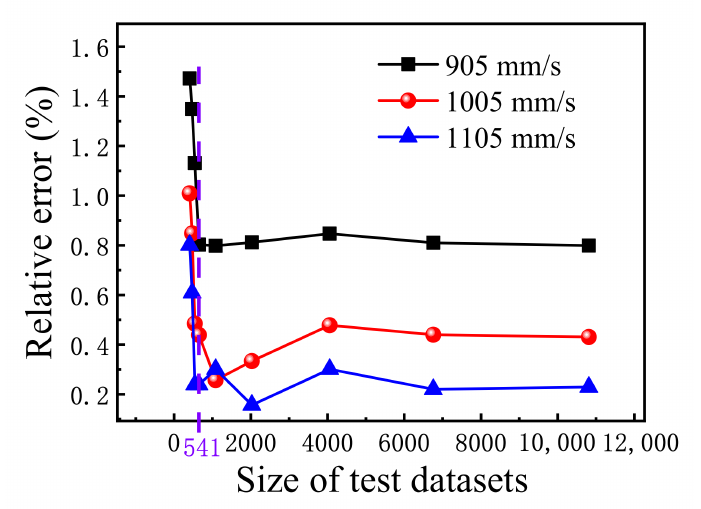
Figure 4. The predicted relative errors from experimental values as a function of dataset size used in the optimized XGBoost model.